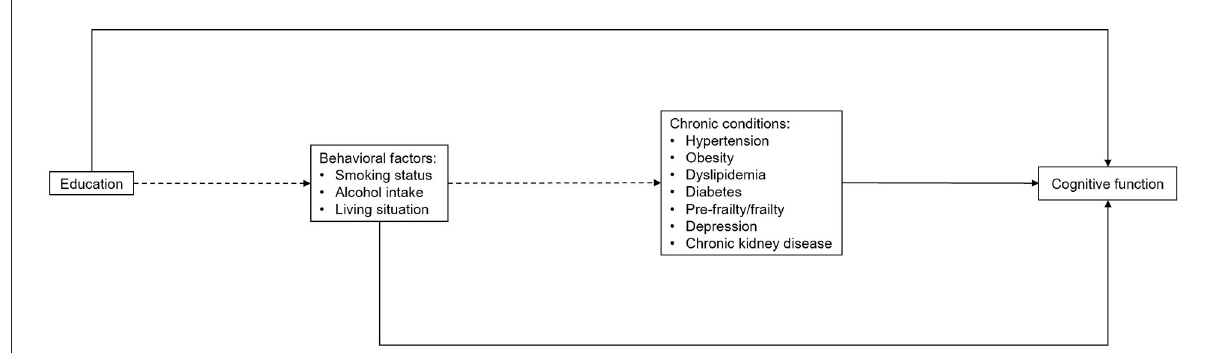
FIGURE1 Theoretical framework of structural equation modeling, including paths sequentially from education to behavioral factors, chronic conditions and cognitive function. Solid arrows refer to the direct associations and dashed arrows refer to the indirect associations with cognitive trajectory subgroups. Age, gender and ethnicity were also included in the full model with arrows to all other variables (not